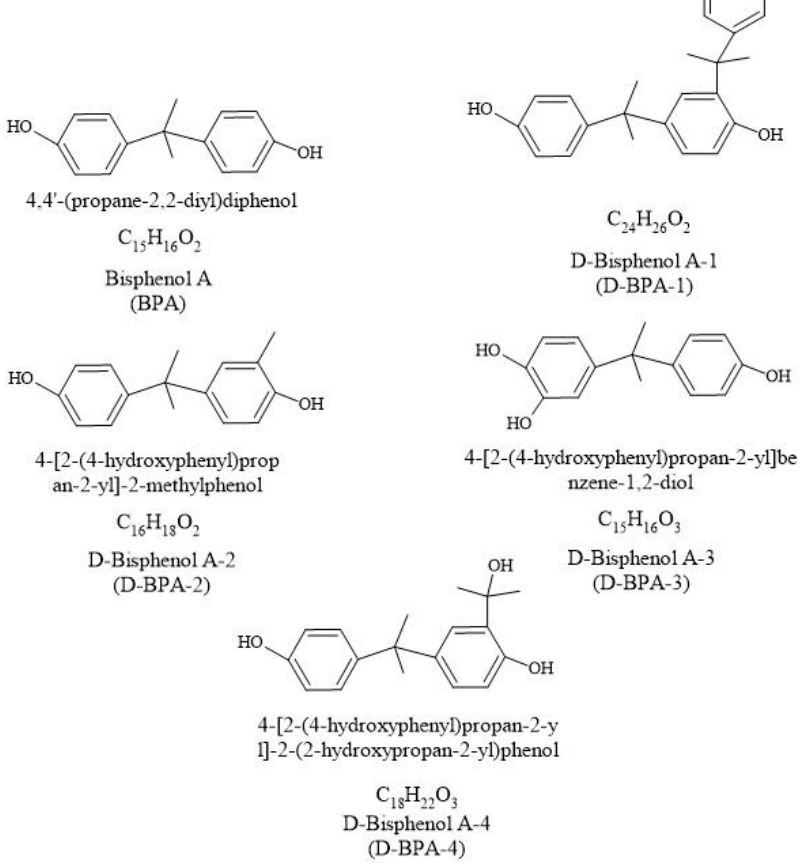
Figure 2. Structures and identifications of the BPs of interest.